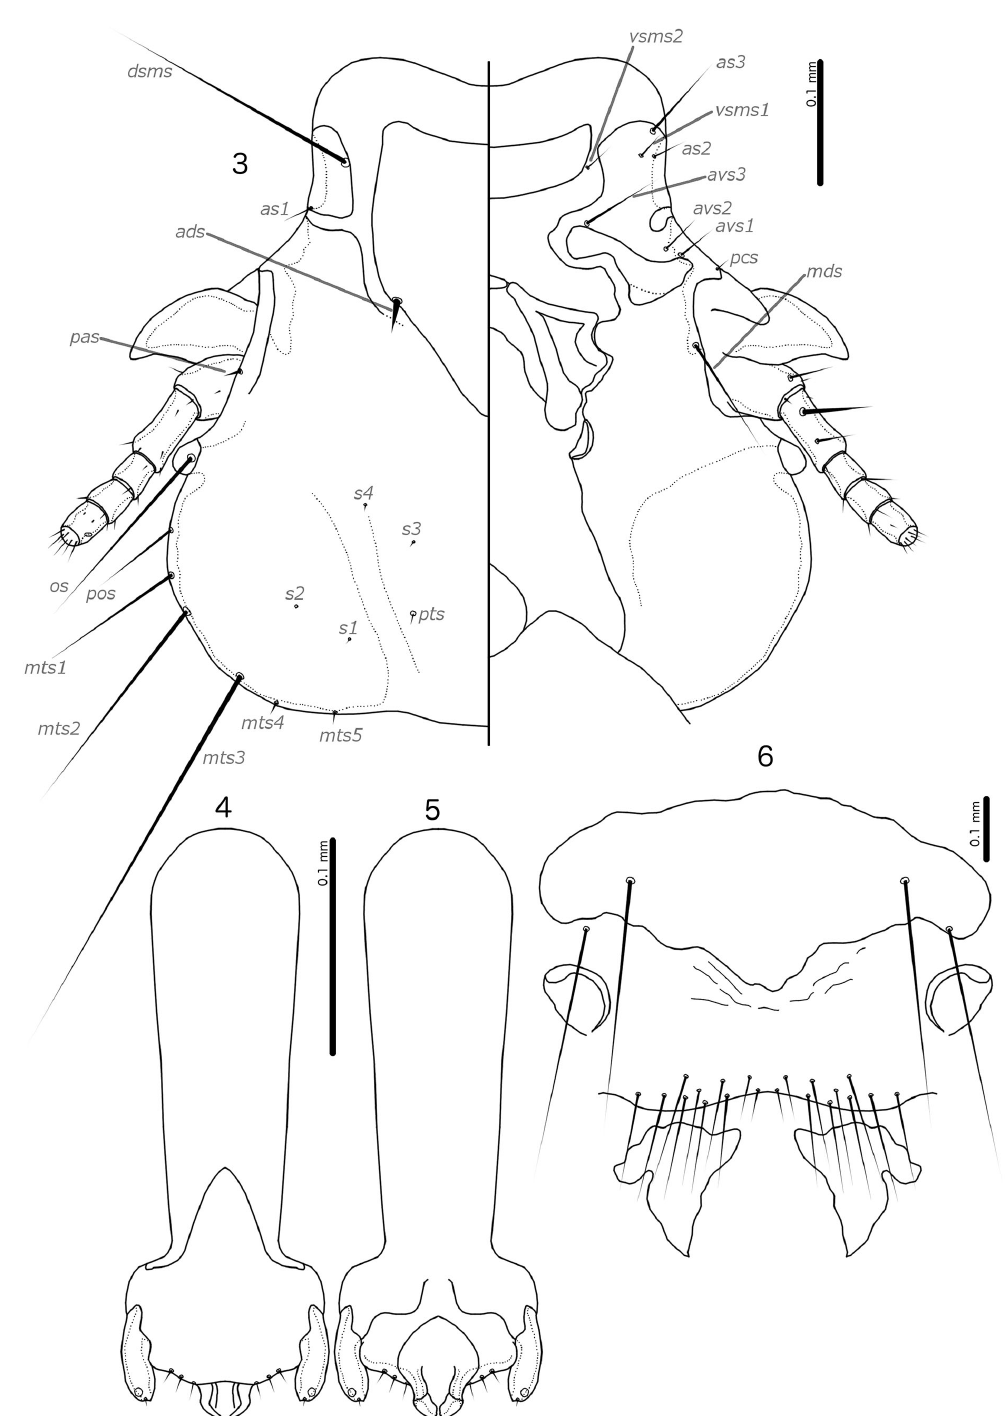
Figs 3–6. Philopterus hebes sp. nov. ex Chloropsis aurifrons inornata Kloss, 1918. 3 . Male head, dorsal and ventral views. 4 . Male genitalia, dorsal view. 5 . Male genitalia, ventral view. 6 . Female subgenital plate, vulval margin, and subvulval plates, ventral view. Abbreviations: ads = anterior dorsal seta; as1–3 = anterior setae 1–3; avs1–3 = anterior ventral setae 1–3; dsms = dorsal submarginal seta; mds = mandibular seta; mts1–5 = marginal temporal setae 1–5; os = ocular seta; pas = preantennal seta; pcs = preconal seta; pos = preocular seta; pts = posttemporal seta; s1–4 = sensilla 1–4; vsms1–2 = ventral submarginal setae